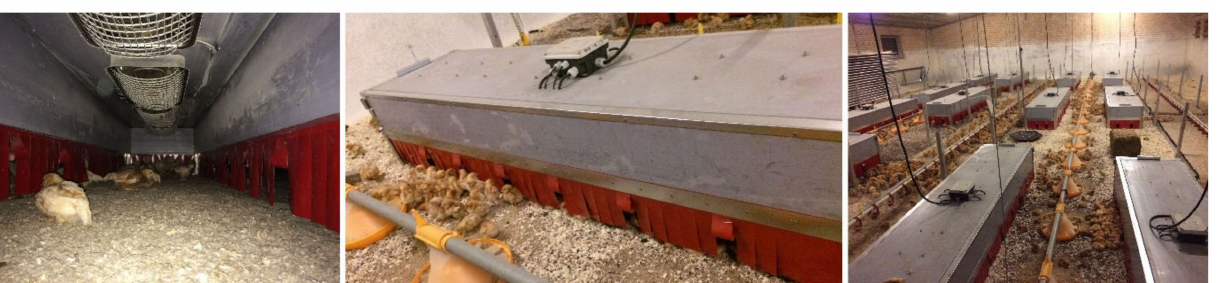
Figure 3. Home-built dark brooders in an organic commercial pullet farm. The brooders have a lid for the farmer to easily inspect the chicks underneath the brooder. Left: inside with heaters mounted on the ceiling, middle: outside with a temperature control system on the top and parts of the fabric fringes lifted to guide the chicks in and out of the brooder and right: barn with brooders positioned between the feeder and drinker lines. ©Tina Bøje